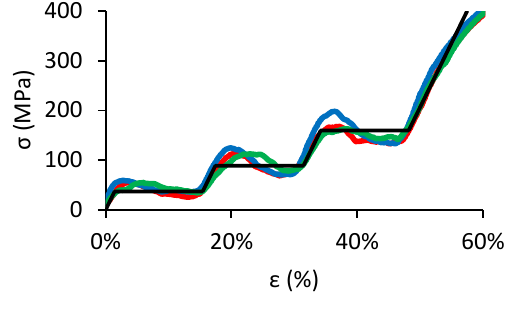
Figure 2. Stress-strain curves of three graded lattices under compressive loading. The blue, red and green lines are the curves for repeat measurements of identical graded lattice structures. The black lines indicate the predicted form of the stress strain curve calculated from the data obtained from tests on lattices of uniform structure. All curves clearly show the collapse of the individual layers and the increasing stress required to further crush the structure.